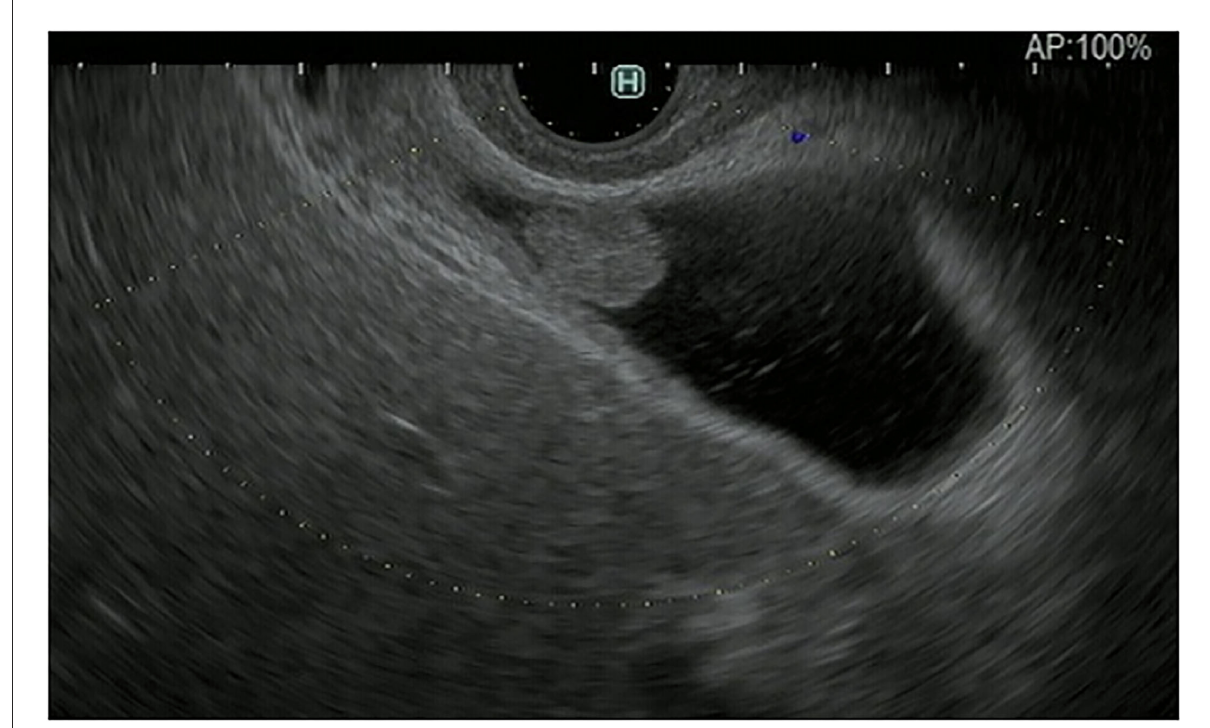
FIGURE1 Fundamental B-mode EUS for gallbladder polypoid lesions. Gallbladder adenoma: iso-echoic homogenous pedunculated mass